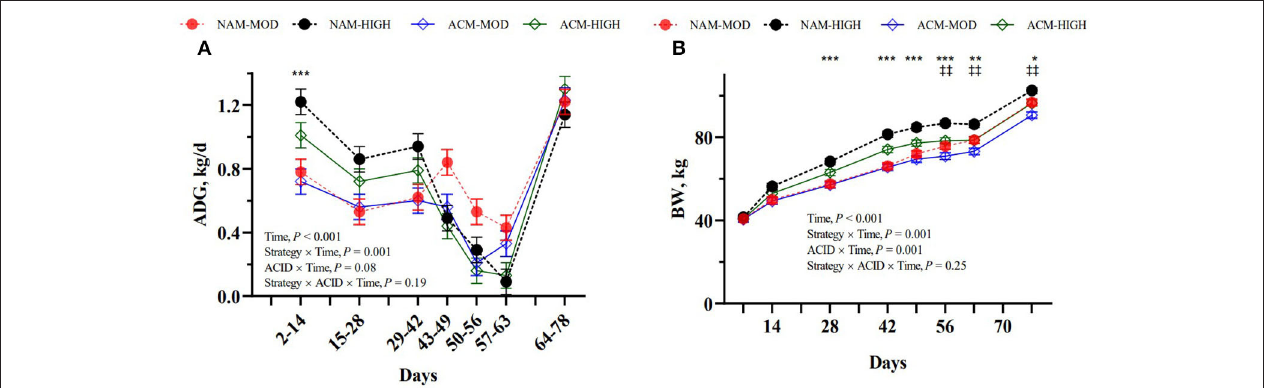
FIGURE 2 | Effect of milk feeding strategy and milk acidification on ADG (A) and body weight (B) in calves assigned to (1) non-acidified milk at 6L (NAM-MOD); (2) acidified milk at 6L (ACM-MOD); (3) non-acidified milk at 12L (NAM-HIGH) and (4) acidified milk at 12L (ACM-HIGH) per day. Strategy: milk feeding strategy (MOD or HIGH). ACID: milk acidification (NAM or ACM). Time for ADG represents the difference in BW between two consecutive days on which BW was measured divided by the number of days in that period. Values are presented as weekly LSM; *Indicates moderate vs. high volume of milk fed (* P < 0.05; ** < 0.01; *** < 0.001); ‡ indicates